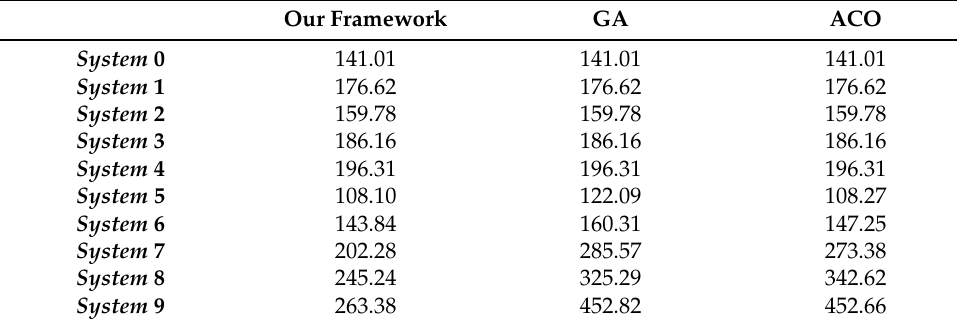
Table 3. Optimal cost results for our framework, GA, and ACO.